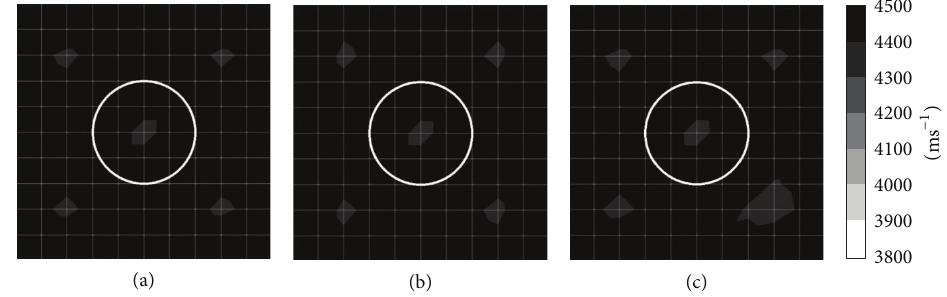
Figure 14: 10mm thick aluminium duct: (a) 0% void; (b) 50% void; and (c) 100%